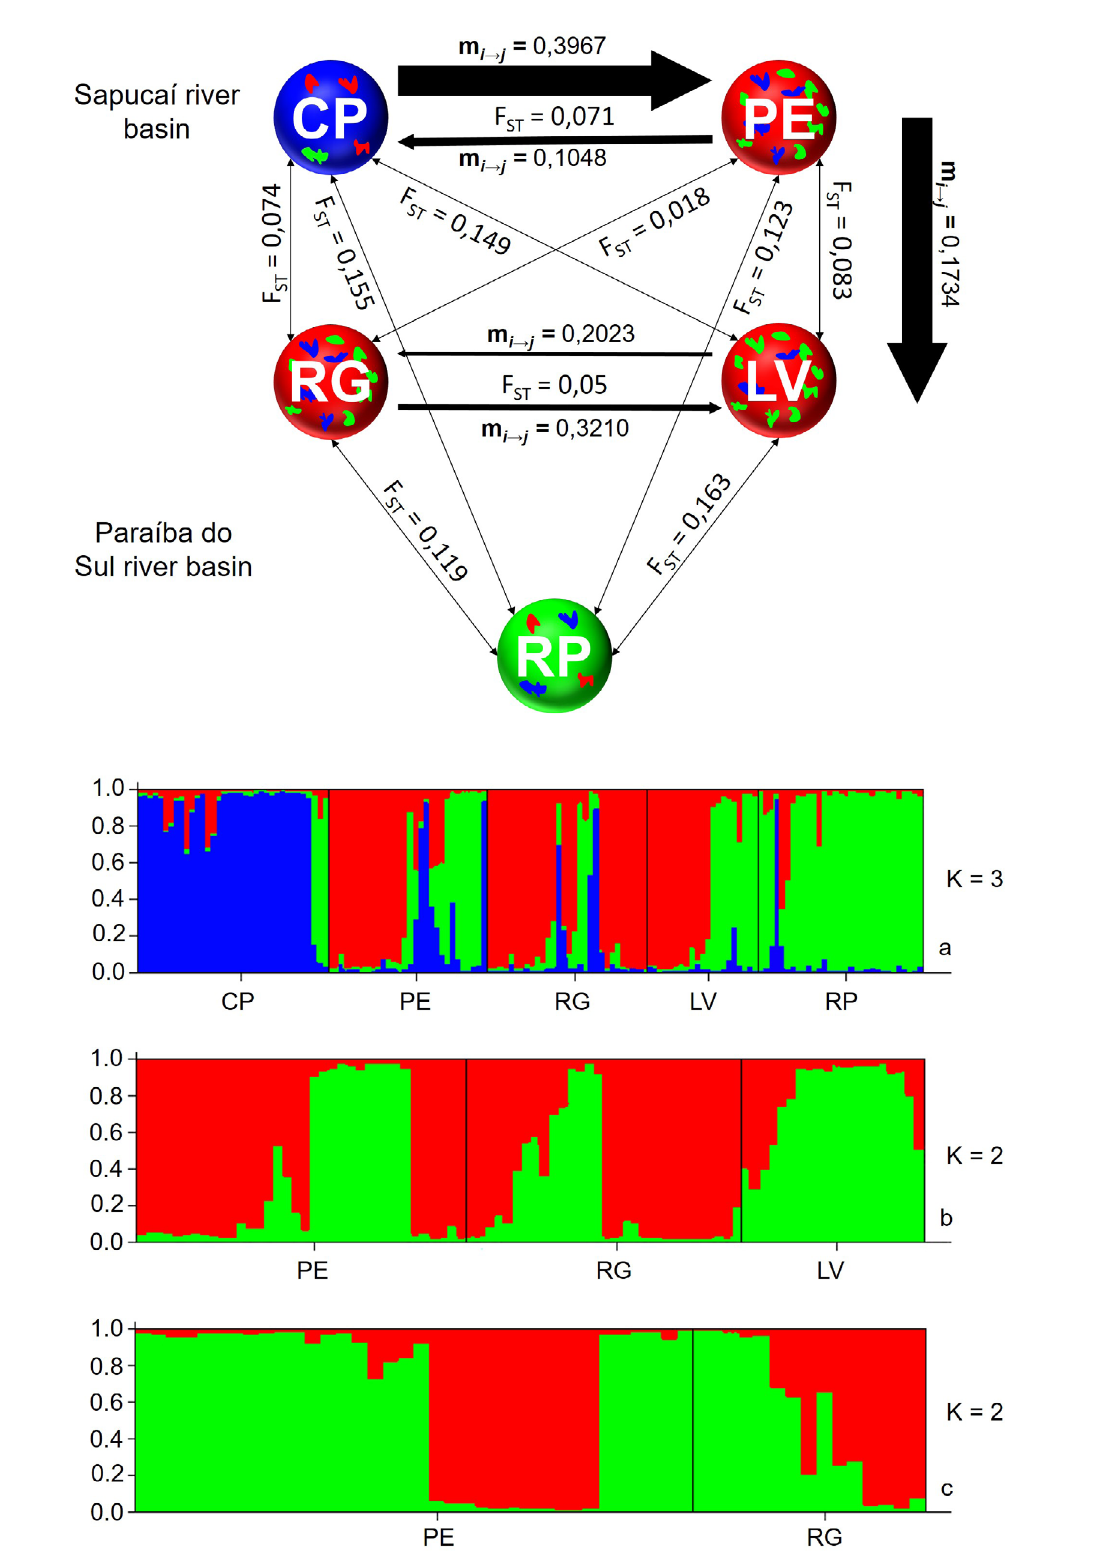
Figure 2 – Results of the genetic structuring analysis of five Psalidodon scabripinnis populations in the Sapucaí and Paraíba do Sul basins. Above, paired F (narrow arrows) and migration rate (m , broad arrows) for the five populations. The thickness of the arrows is proportional to the migration ST i → j rate. Non-significant values for the migration rate are not shown (P < 0.05, for all values of F ). Below, STRUCTURE results with the three runs (a: ST CP+PE+RG+LV+RP; b: PE+RG+LV; c: